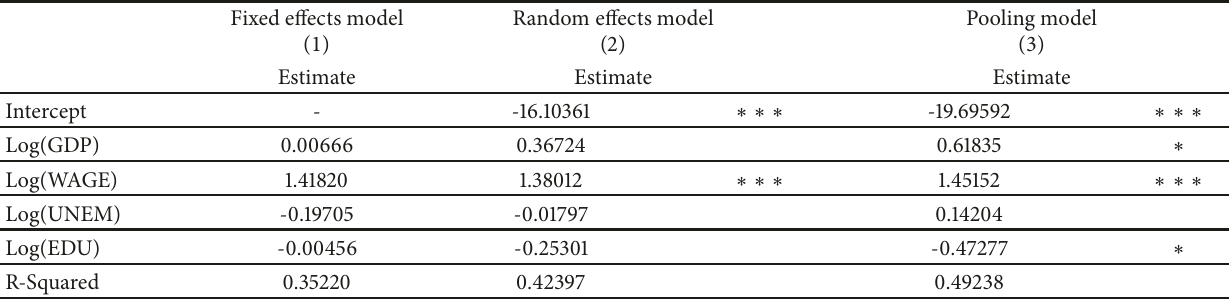
Table 4: Estimated coefficients of linear panel